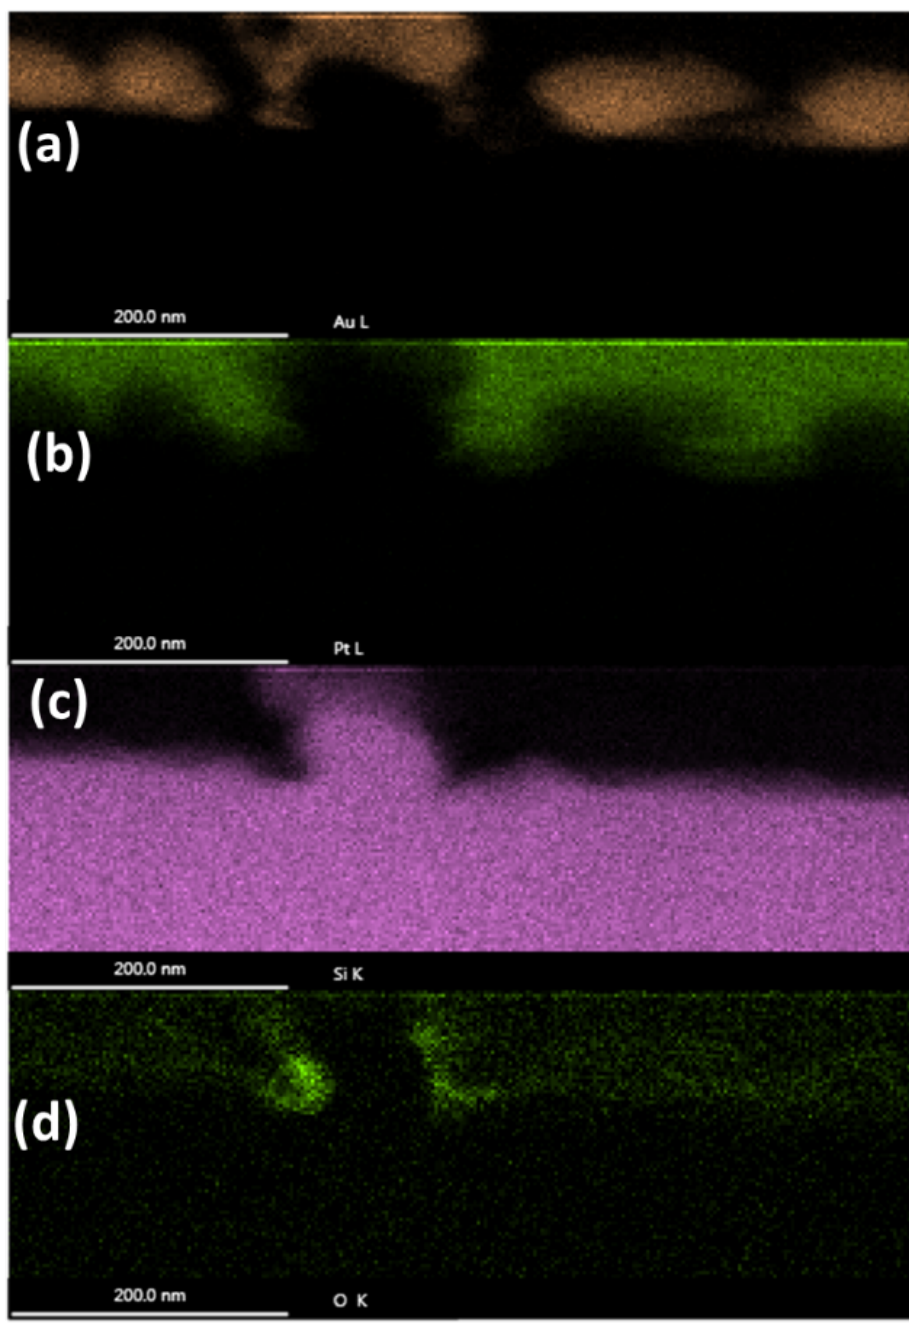
Figure 12. Spatially resolved Energy-dispersive X-ray spectroscopy (EDX) of an NSC outgrowth. The EDX is taken at location Y of the cross-sectional TEM sample. The peak signal count value is plotted for Au ( a ), Pt ( b ), Si ( c ), and O ( d ). A proprietary algorithm used by the EDX software is able to plot spatially resolved EDX of several elements simultaneously while allowing for the colors to be mixed if both elements are present at the same location. This is shown in Figure